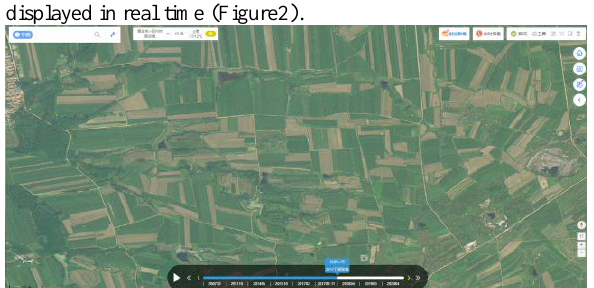
Figure2 . Multi-temporal image service of Shandong node